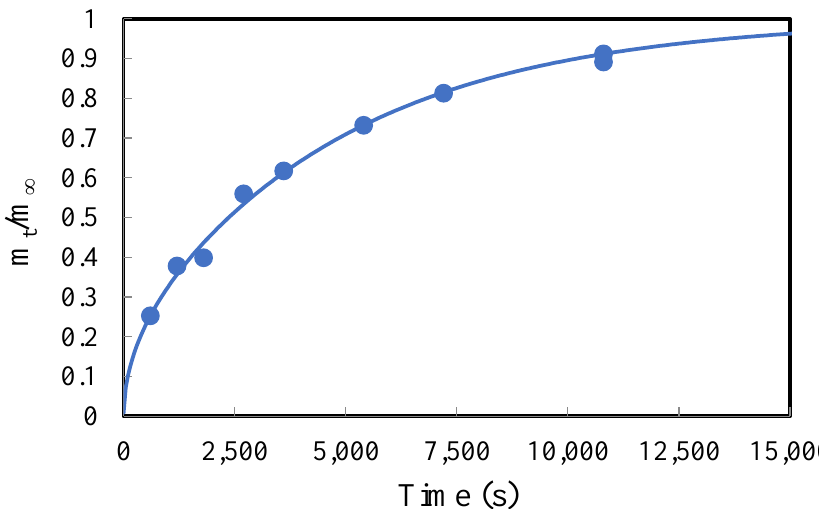
Figure 3. Example of solvent absorption in membrane samples. The solvent in this example is 1-butanol, the membrane is PDMS without imbedded particles, and the membrane half-thickness, l, is 0.425 mm. Table 3. Summary of solvent absorption in PDMS membranes.